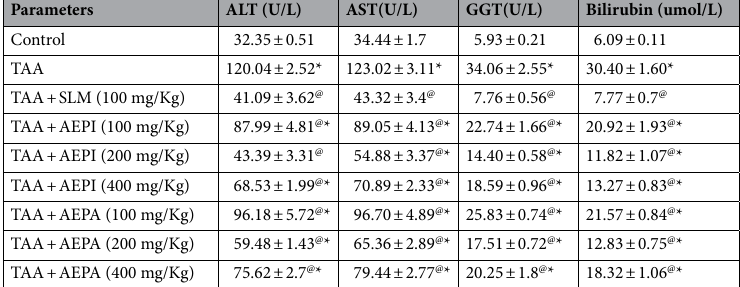
Table 2. Effect of pretreatment with hydroalcoholic extracts of the aerial parts of P. indica or P. auriculata on serum hepatic functions biomarkers in TAA-induced liver toxicity in rats. Results were expressed as Mean ± S.D., n = 5. SLM: Silymarin, * ,@ Significantly different from normal control and TAA groups at p > 0.05,